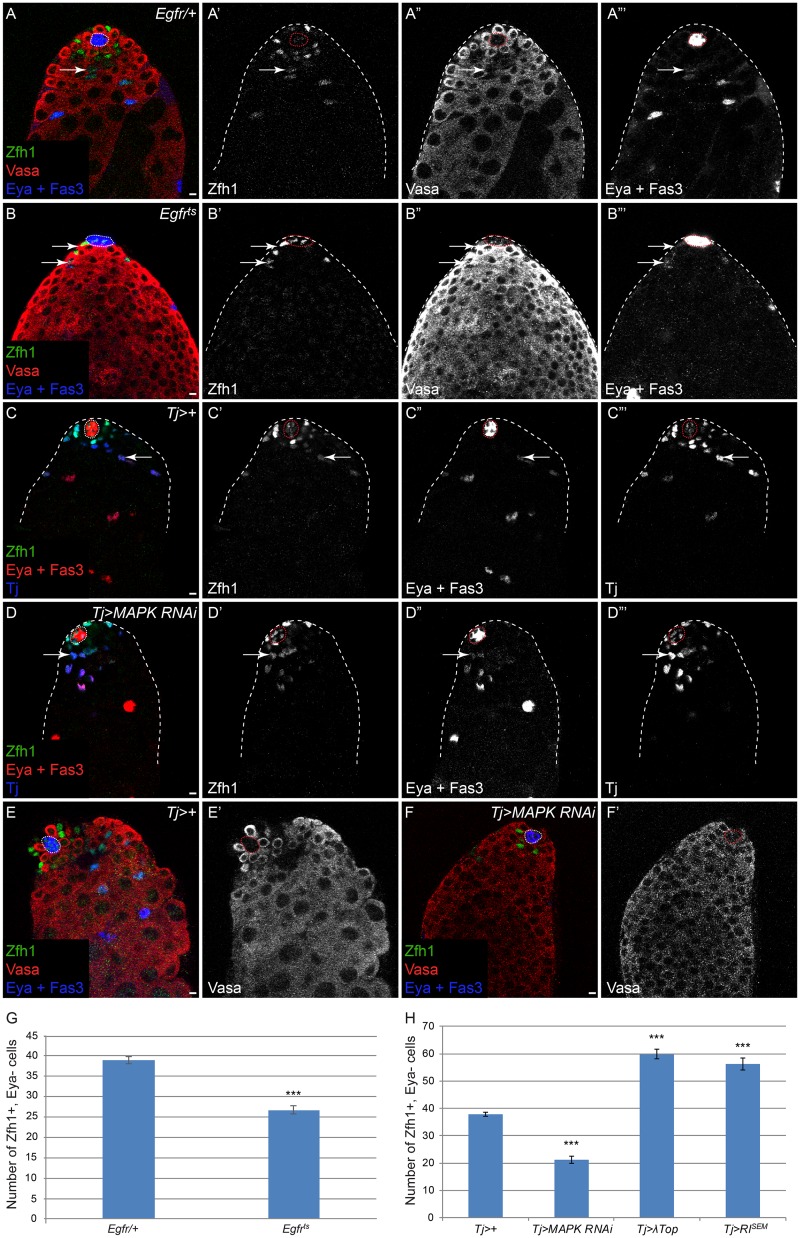
MAPK signaling regulates CySC numbers.A) A representative testis from an Egfr/+ animal contains a rosette of GSCs in contact with the niche surrounded by a row of Zfh1-positive CySCs. The arrow highlights a differentiating cyst cell that has started to express Eya. B) A testis from an Egfrts animal that was upshifted to the restrictive temperature of 29°C for 10 days. Note the accumulation of many small Vasa-positive early germ cells and a reduction in the number of Zfh1-positive cells. Arrows mark somatic cells close to the niche that have turned on expression of the differentiation marker Eya. C) Markers of the somatic lineage in a control Tj-Gal4 (Tj>+) testis. Tj (blue) is expressed at low levels in the hub and at higher levels in CySCs and early cyst cells. Zfh1-positive CySCs (green) are observed near the niche and Eya (red) begins to be expressed in differentiating cyst cells. Arrow marks a differentiating cyst cell that is several rows away from the niche and that has upregulated expression of Eya. D) Tj>MAPK RNAi testis. Note the reduction in Zfh1-positive cells and upregulation of Eya in somatic cells close to the niche, which is not observed in controls (compare to arrow in C). E) A normal complement of Vasa-positive GSCs and large differentiating spermatogonia in a control Tj-Gal4 (Tj>+) testis. F) In a Tj>MAPK RNAi testis, there is a block in germ cell differentiation, an accumulation of many small early germ cells and a total lack of differentiating spermatogonia, similar to Egfrts testes at the restrictive temperature (see B). G,H) Graphs showing the number of CySCs, defined as Zfh1-positive, Eya-negative cells, in Egfr/+, Egfrts, control (Tj-Gal4), Tj>MAPK RNAi, Tj>λTop, and Tj>RlSEM testes. (G) Note a significant drop in CySCs in Egfrts testes compared to Egfr/+. H) Note significant decrease in CySCs in Tj>MAPK RNAi testes compared to control and a significant increase in the number of CySCs in Tj>λTop and Tj>RlSEM testes (see S1 Table for “n” values). Vasa is red in A,B,E,F. Zfh1 is green in all panels. Fas3 and Eya are blue in A,B,E,F and red in C,D. The hub is outlined by a dotted line. Scale bar = 5 μM.